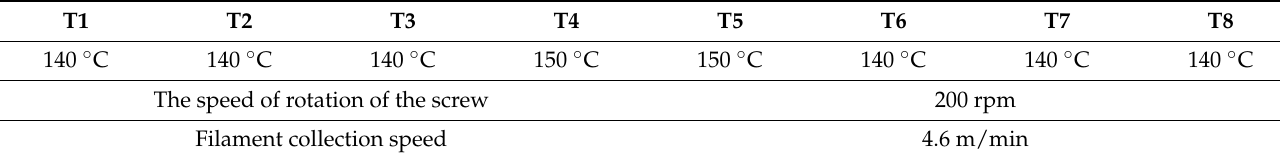
Table 2. Printing parameters.